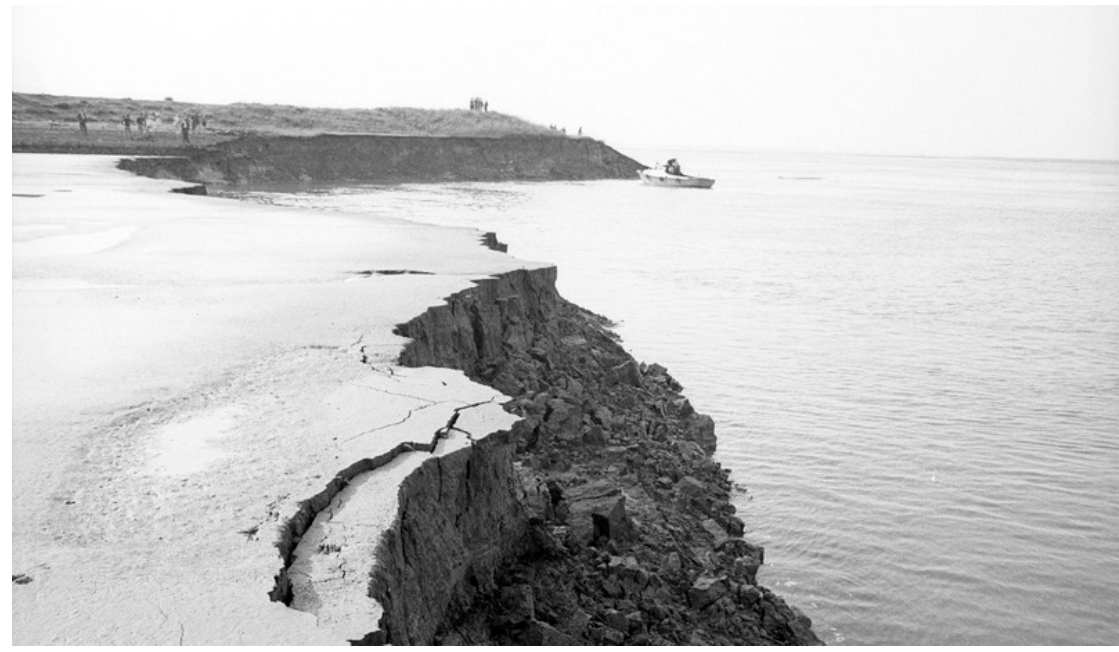
Figure 4. Partial dike collapse following a flow slide event at Hoofdplaatpolder, Western Scheldt, Netherlands, 1964. Photo: Beeldbank Zeeland Zeeuwse Bibliotheek.